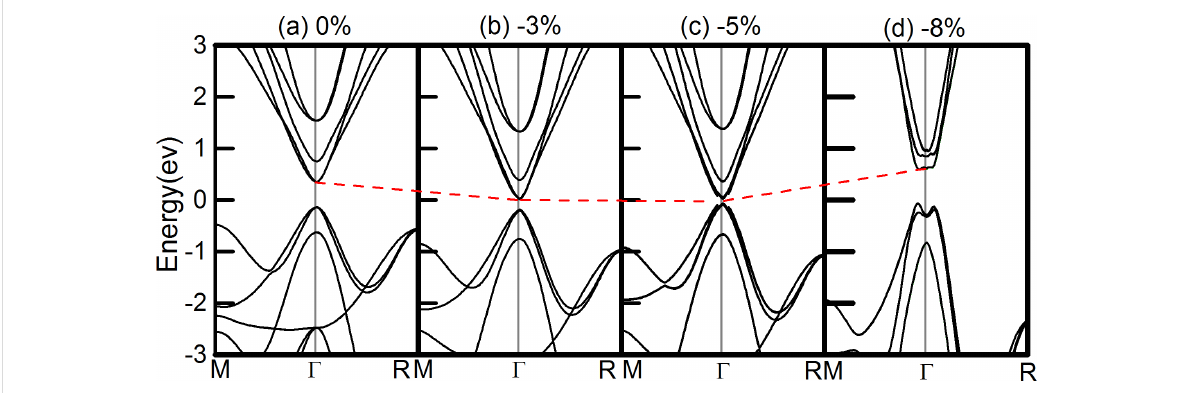
Figure 3: Band structures of ThTaN 3 calculated by the HSE+SOC method under a strain of − 8% to 0%. The Fermi level is set to zero.